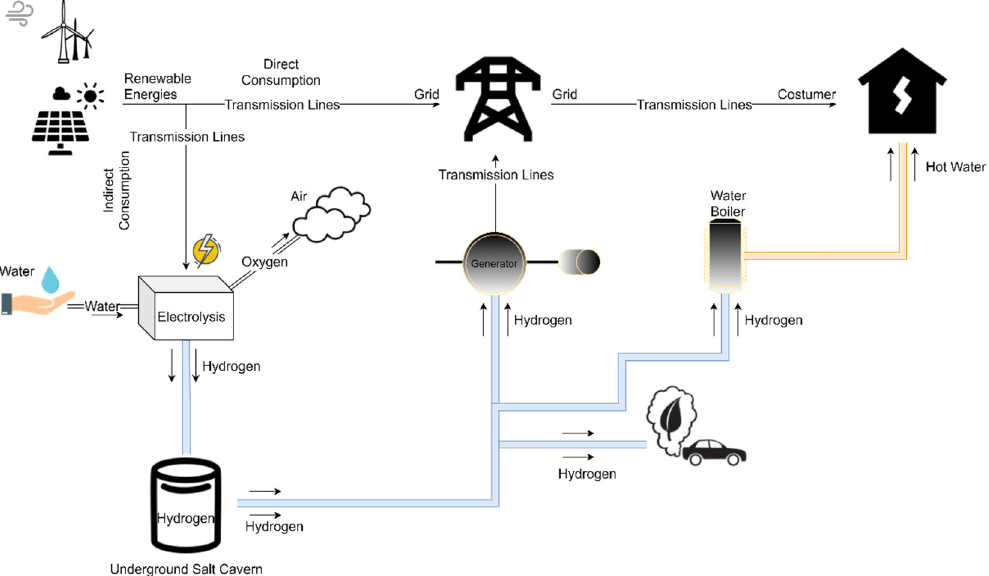
Figure 3. Hydrogen production, storage and its applications integrated to the energy system.